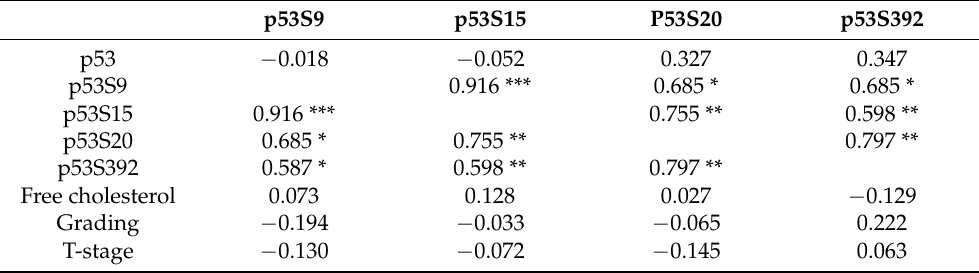
Table 2. Correlation of p53S9, S15, S20 and S392 with p53, free cholesterol, grading and T-stage in the HCC tissues of all patients. * p < 0.05, ** p < 0.01, *** p <